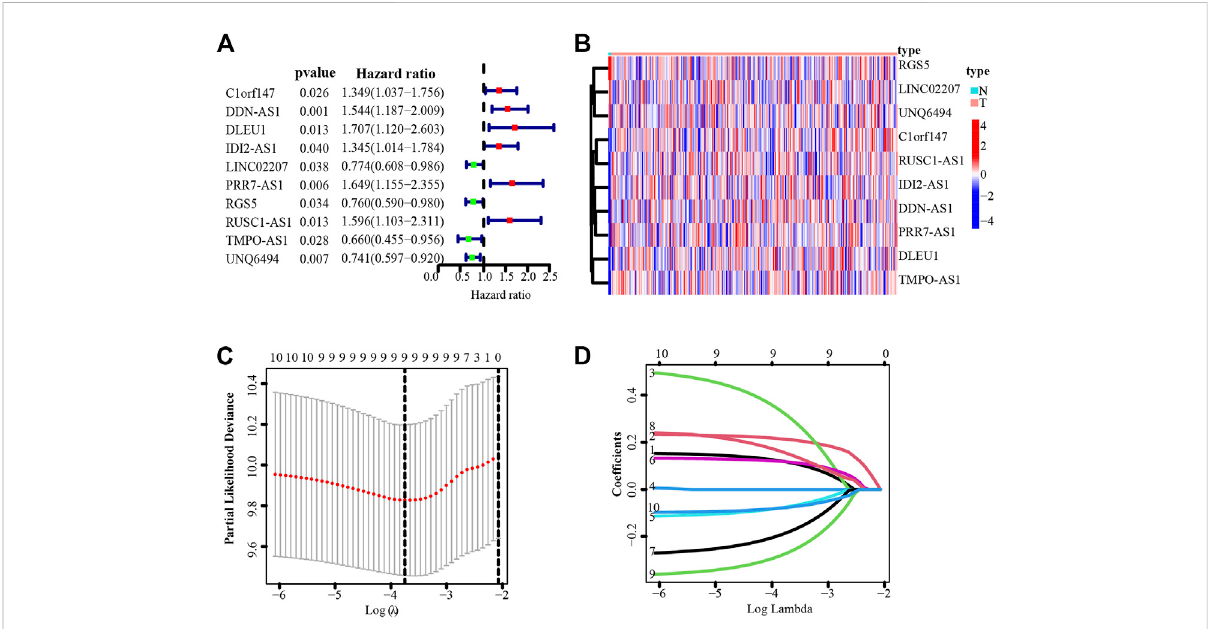
FIGURE 2 I denti fi cation ofnecroptosis-related lncRNAs withprognostic value incervical cancer patients. (A) Forest plotshowed the prognostic risk value ofthe10necroptosis-relatedlncRNAs via univariateCoxregressionanalysis. (B) Heatmapof10necroptosis-relatedlncRNAs. (C) Cross-validationfor optimizing the parameter in LASSO regression. (D) The in fl uence of log lambda on the weight coef fi cients of each independent variable.